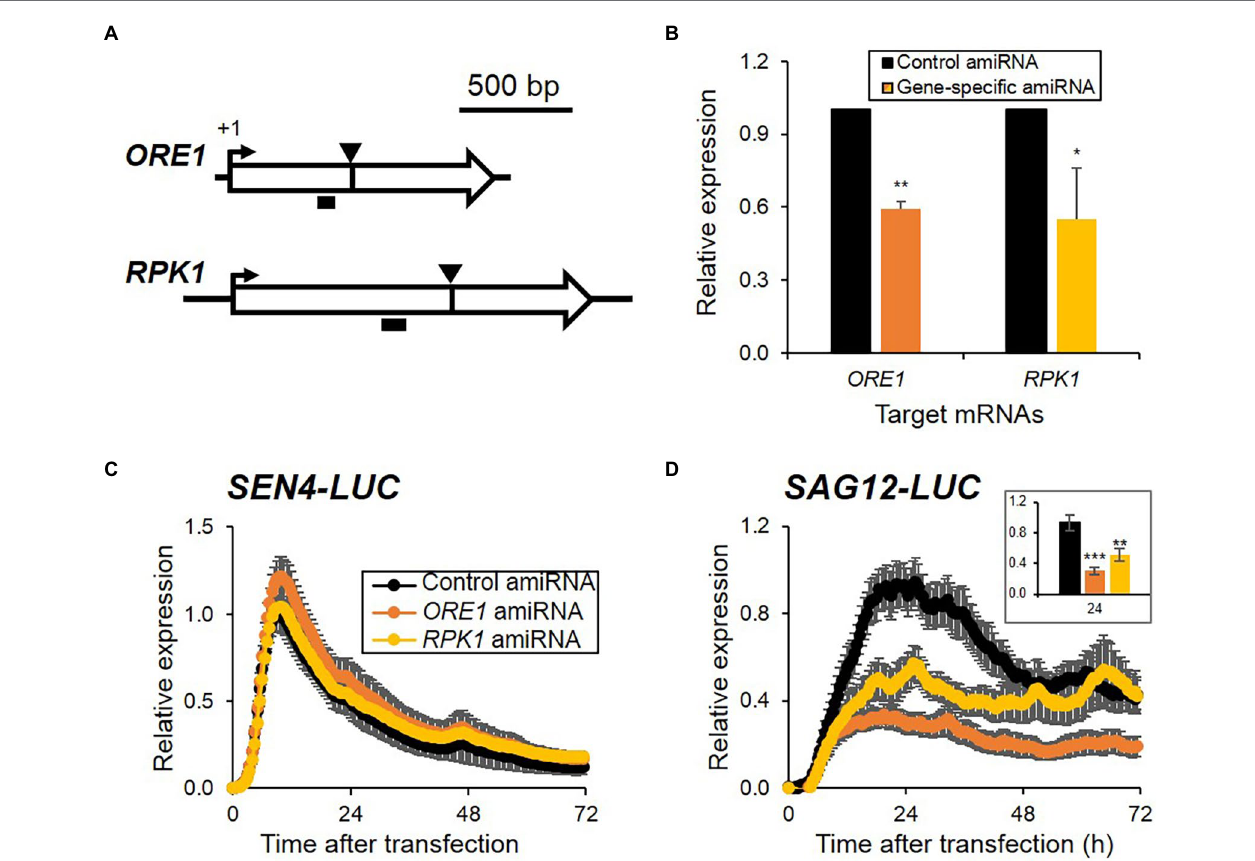
FIGURE 3 | Expression patterns of SEN4- (A) and SAG12-LUC (B) reporters by reduced expression of senescence regulators using amiRNAs. (A) Schematic of the ORE1 and RPK1 with the amiRNA-targeted site (arrowheads) and the PCR amplified region (horizontal black bars) indicated for each. (B) Relative expression of ORE1 and RPK1 from protoplasts transfected with control or the gene-specific amiRNA indicated and harvested at 16 h incubation under dim light after transfection. Data represent mean ± SE ( n = 3). (C,D) Bioluminescence traces of SEN4- (C) and SAG12-LUC (D) with amiRNA-construct gene targeting ORE1 or RPK1 during darkness. Symbols in (D) are the same as in (C) . (Inset) Bar graph of relative expression of SAG12-LUC at 24 h after transfection. Luciferase activity of LUC was normalized to the maximum level of RLUC over the assay. Relative expression of SEN4- (C) and SAG12-LUC (D) was calculated by normalization to the maximum level of LUC/RLUC throughout the measurement in protoplasts transfected with control amiRNA in each trial. Data represent mean ± SE ( n = 6). A statistical analysis was performed using a two-tailed Student’s t -test (* p < 0.05; ** p < 0.01; and *** p <